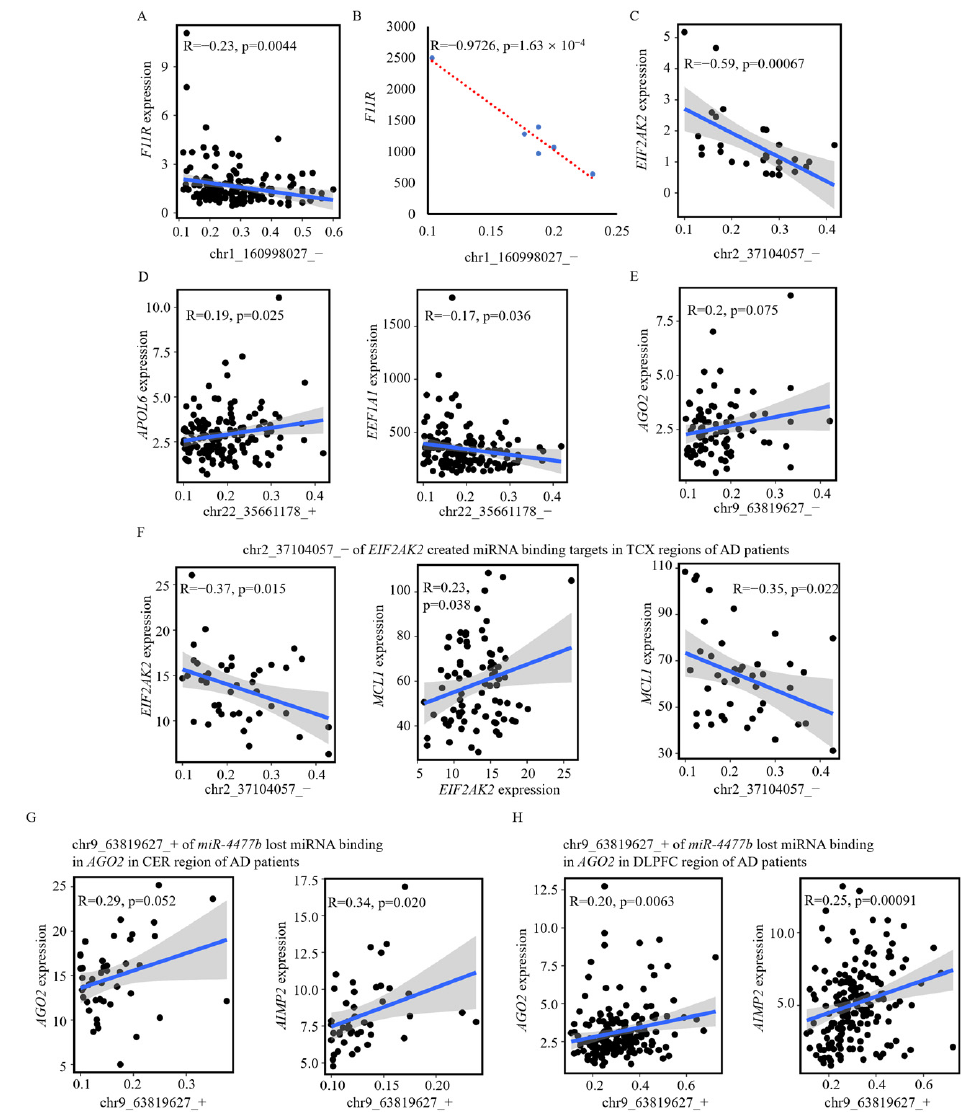
Figure 6. The effects of RNA editing events on genes in other datasets. ( A , B ) In blood samples of PD patients from PPMI and GEO (GSE165082), the RNA editing event at Chr1:160998027 shows significant associations with F11R . ( C – E ) In healthy blood samples, the three RNA editing events discussed in detail also show significant associations with corresponding genes. ( F ) In temporal cortex (TCX) regions of AD patients, the RNA editing event at Chr2:37104057 is significantly associated with EIF2AK2 and MCL1 . ( G , H ) In cerebellum (CER) and dorsolateral prefrontal cortex (DLPFC) regions of AD patients, the RNA editing event (Chr9:63819627) in the seed region of miR-4477b may dysregulate AGO2 and AIMP2 .